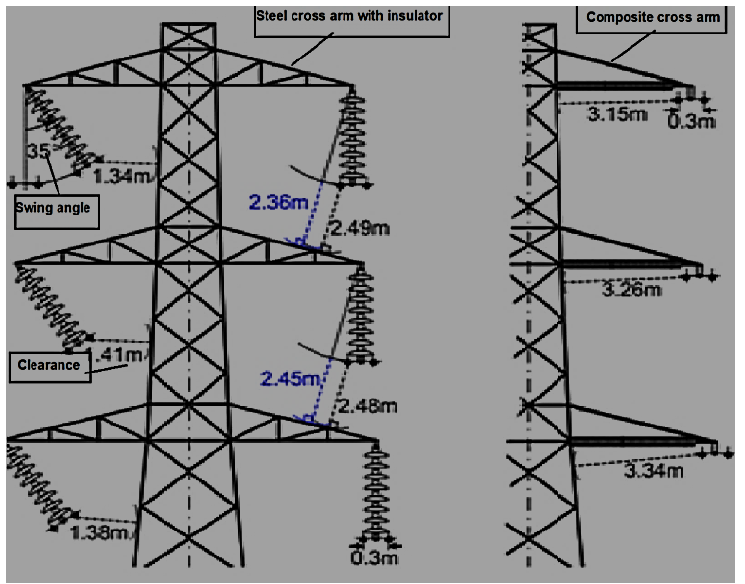
Figure 11. Clearances of 275 kV L3 ‐ type tower with regular suspension and modified composite cross ‐ arm [33].